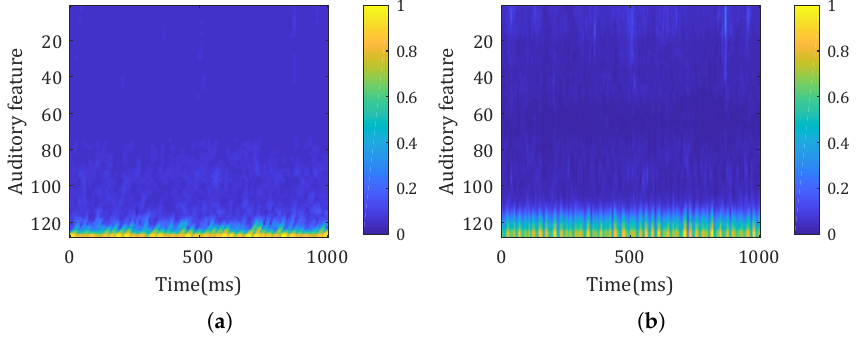
Figure 5. Comparison of learned spectrogram and gammatone spectrogram. ( a ) Learned spectrogram. ( b ) Gammatone